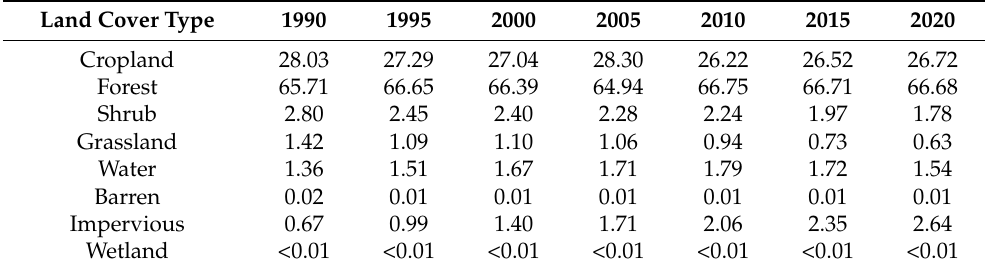
Figure 9. The changes in the proportion of different land covers and soil erosion rate from 1990 to 2020. Table 2. Percentage of land cover in the GPRB from 1990 to 2020 (%).